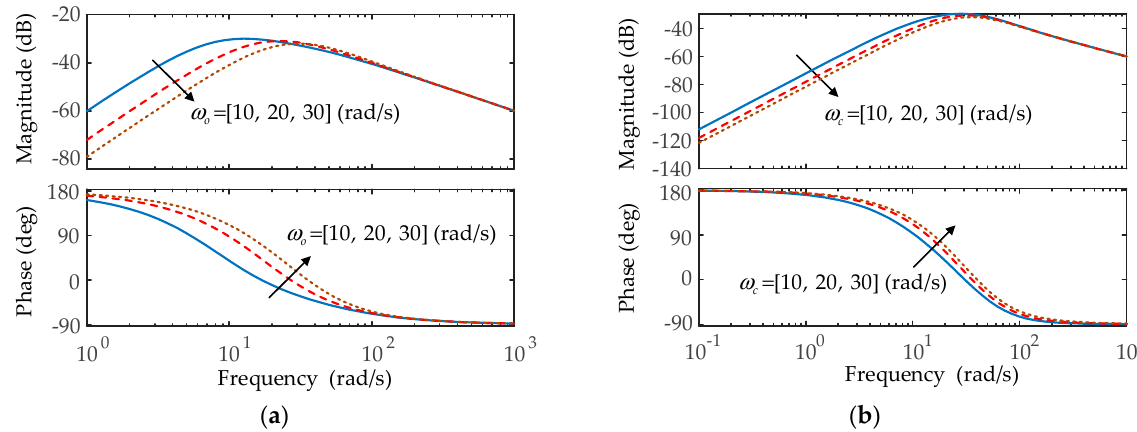
ω ω is fixed at 10 rad/s; ( b ) is fixed at c o